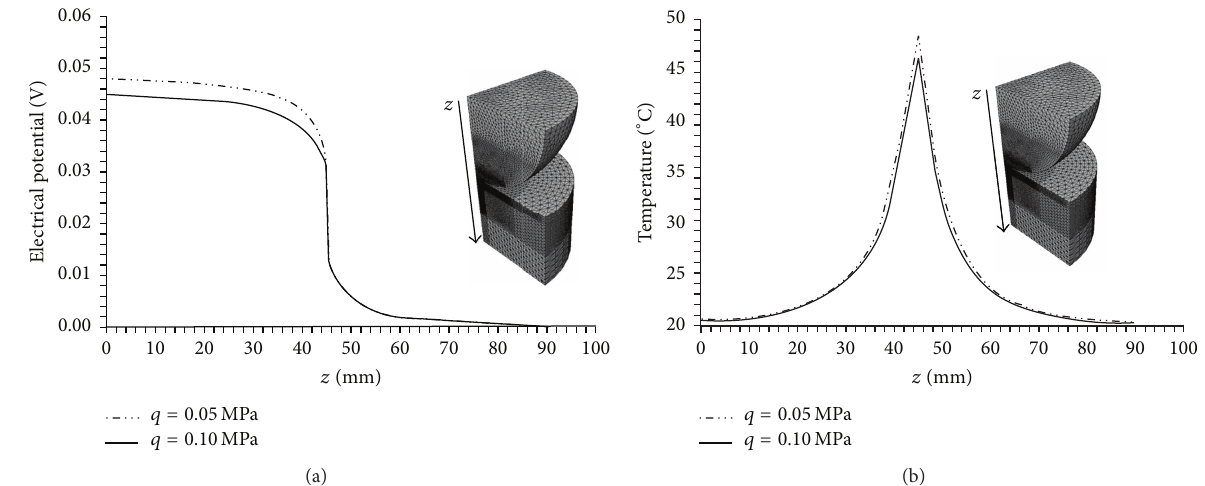
Figure 21: Comparison between electrical potential versus position at different loads levels (a); comparison between temperature versus position at different loads levels